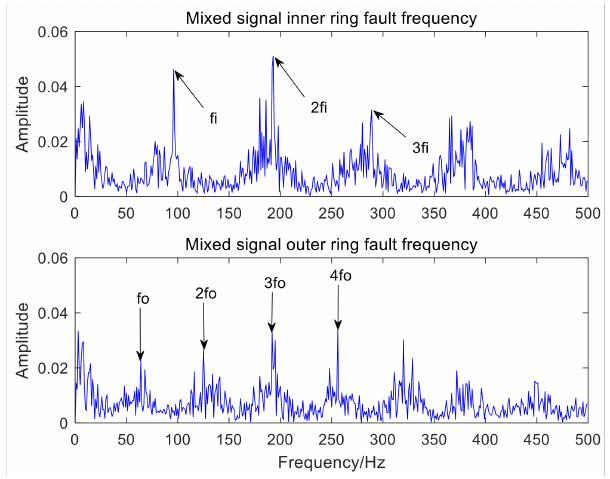
Figure 9. Envelope spectrum results using the